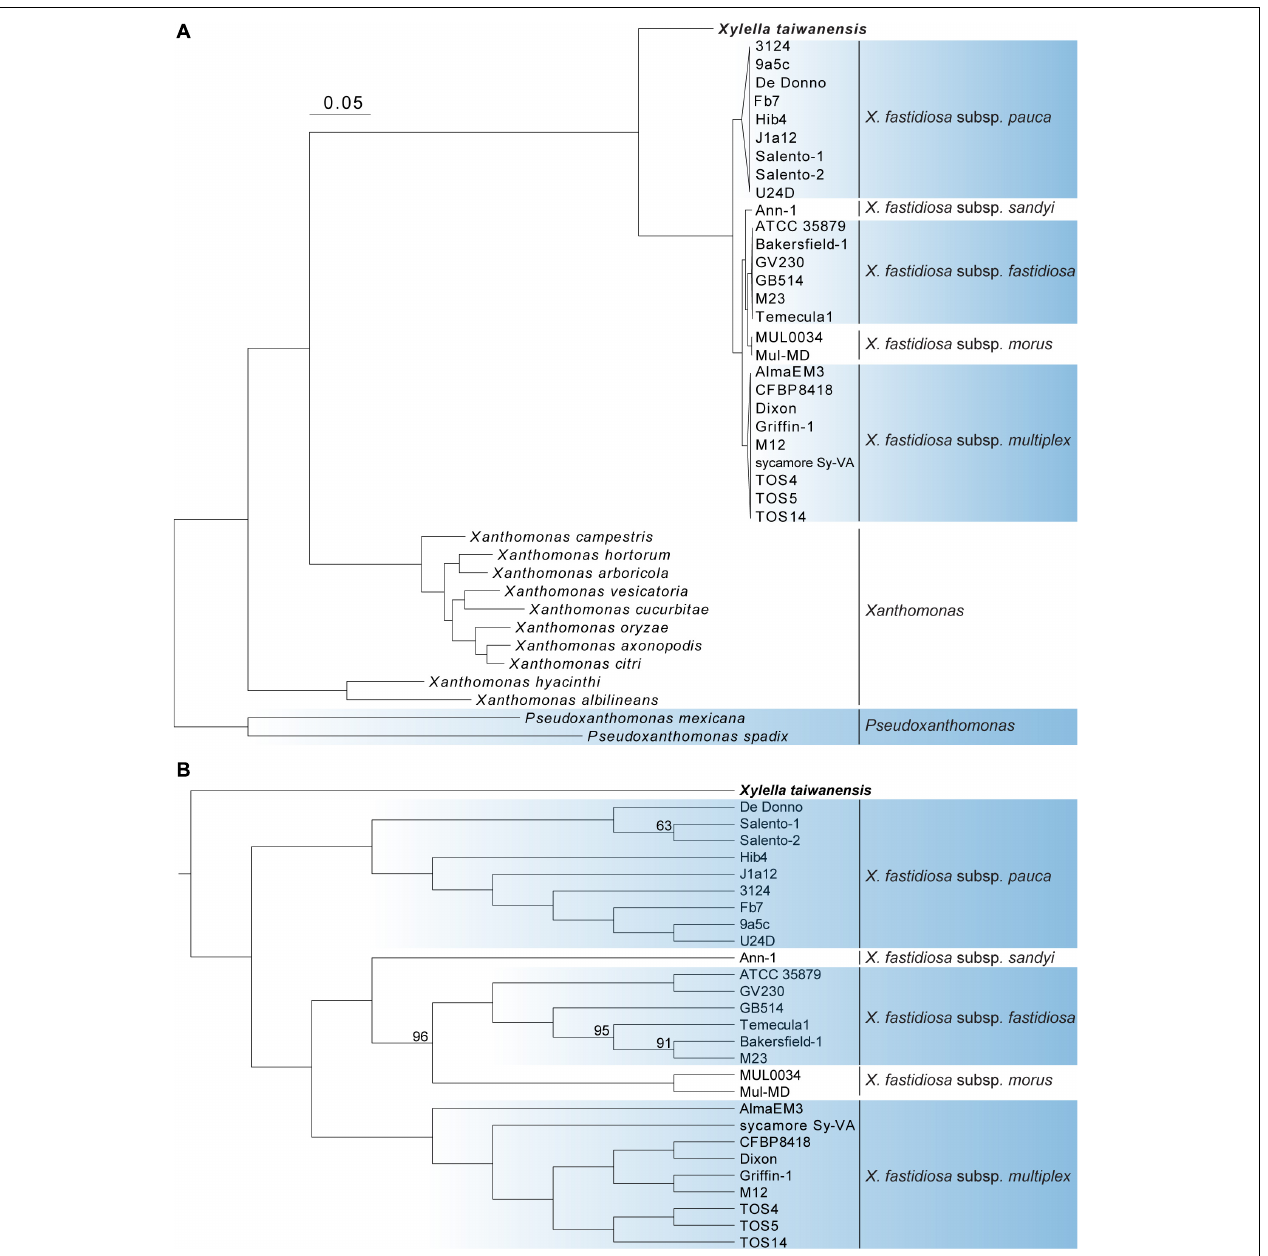
FIGURE 1 | Molecular phylogeny of Xylella and related species in the family Xanthomonadaceae. The maximum likelihood phylogeny was based on 779 shared single-copy genes, the concatenated alignment contains 252,319 aligned amino acid sites. The genus Pseudoxanthomonas was included as the outgroup. (A) A phylogram for illustrating the relationships among all 40 genomes analyzed. Each of the X. fastidiosa subspecies was collapsed into a triangle for simplified visualization. All internal nodes illustrated in this phylogram received > 95% bootstrap support based on 1,000 replicates. (B) A cladogram for illustrating the relationships among those 28 Xylella genomes analyzed. Internal nodes with bootstrap values lower than 100% were labeled.